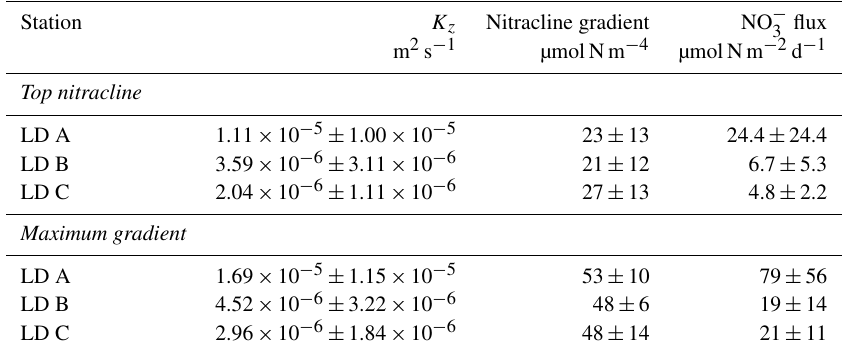
Table 3. Mean turbulent diffusion coefficient ( K z ), mean nitracline gradient, mean NO − the station occupation at LD A, LD B and LD C at the top nitracline and at the maximum